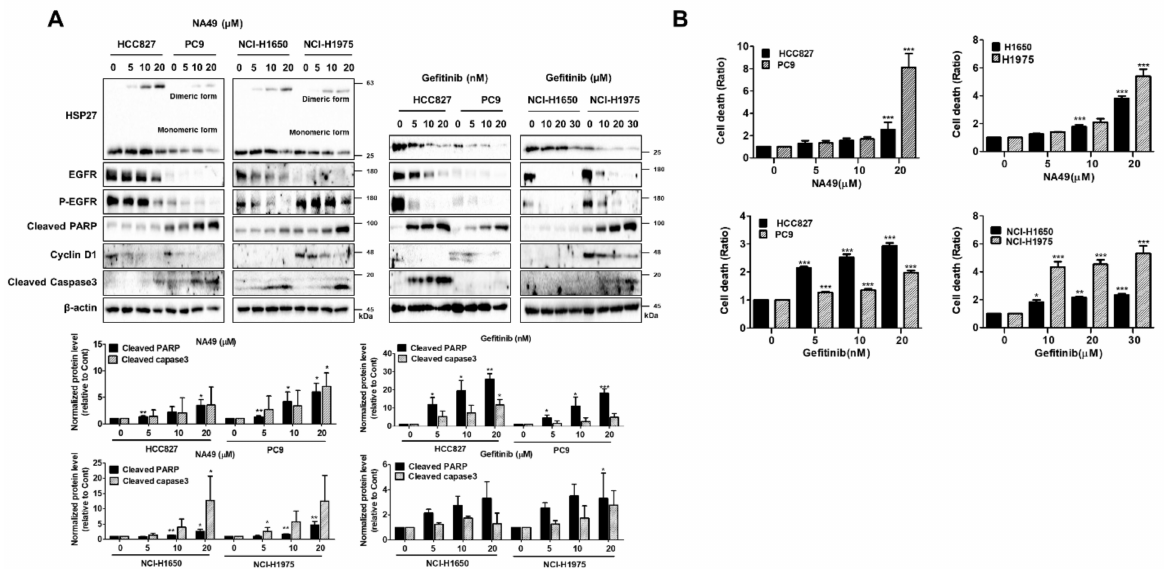
Figure 4. HSP27 cross-linking activities of NA49 and effect of gefitinib in EGFR mutant-type lung cancer cell lines. ( A ) NCI- H1650 and NCI-H1975 cells were treated with NA49 (0, 5, 10, and 20 µ M) or gefitinib (0, 10, 20, and 30 µ M) for 24 h, and cell lysates were detected by Western blot analysis. Protein levels were quantified using Image J software. The data were expressed as the fold change relative to the control and normalized to β -actin in graph. ( B ) NCI-H1650 and NCI-H1975 cells were treated with NA49 (0, 5, 10, and 20 µ M) or gefitinib (0, 10, 20, and 30 µ M) for 48 h, and cell death was analyzed by flow cytometry after propidium iodide (PI) staining. Results are the mean and standard deviation of three independent experiments (* p < 0.05, ** p < 0.01, *** p < 0.001 vs. untreated control